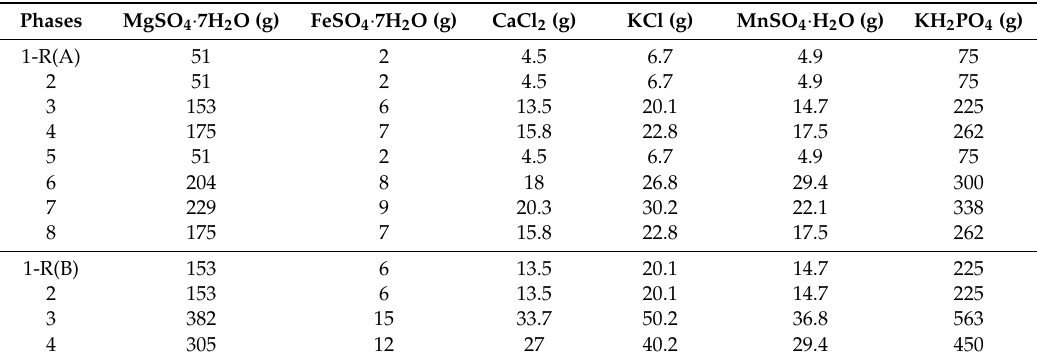
Table 1. Mineral medium concentration in each